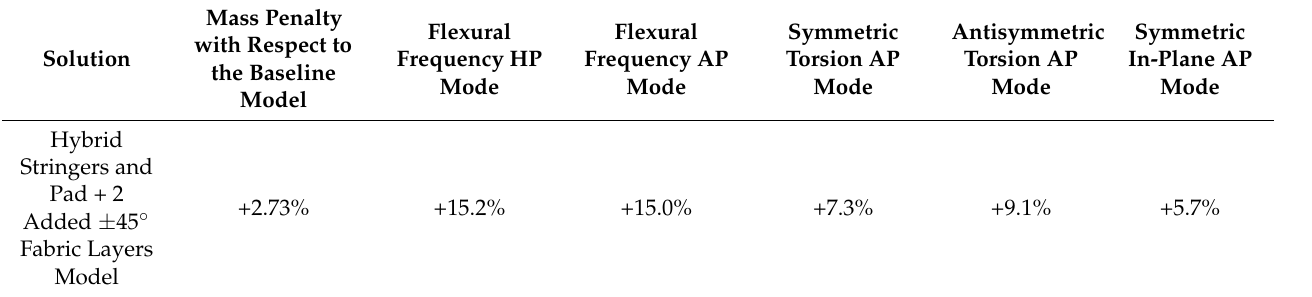
Table 4. Wing Dynamic Status: Helicopter and Aircraft Modes for Hybrid stringers and Pad + 2 Added ± 45 ◦ fabric layers